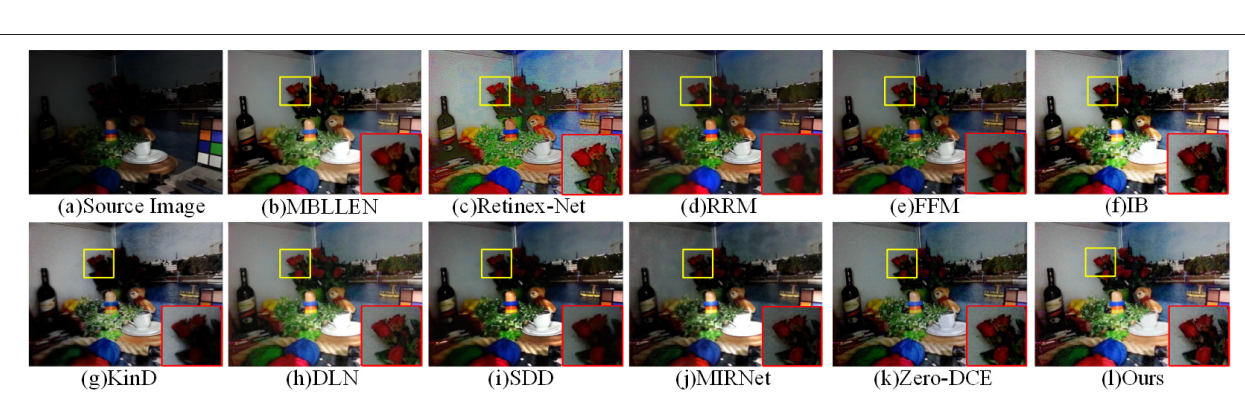
FIGURE 9 | Comparison of the visual effects of our method and other low-light enhancement methods in LIME dataset. The yellow box shows the selected detail content and the red box shows the detail magnification. (A) is the original image, (B–K) is the other 10 low-light enhancement methods, and (I) is our method.